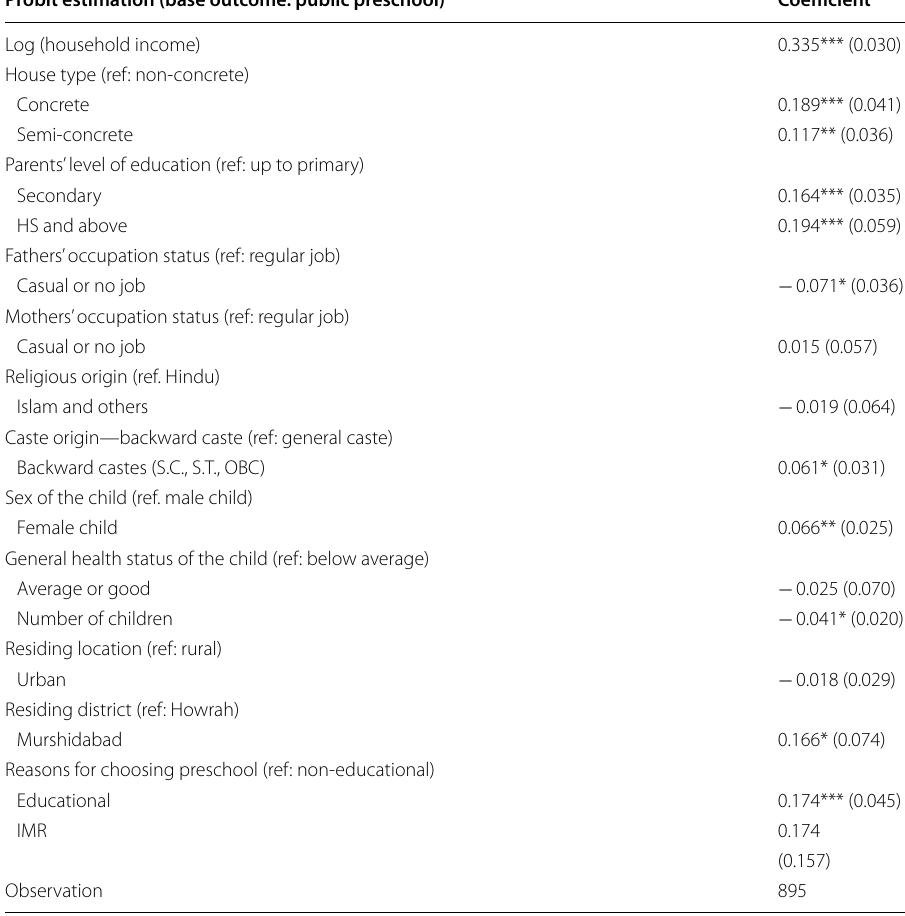
Table 3 Determinants of preschool choice of the parents: marginal effects of Probit